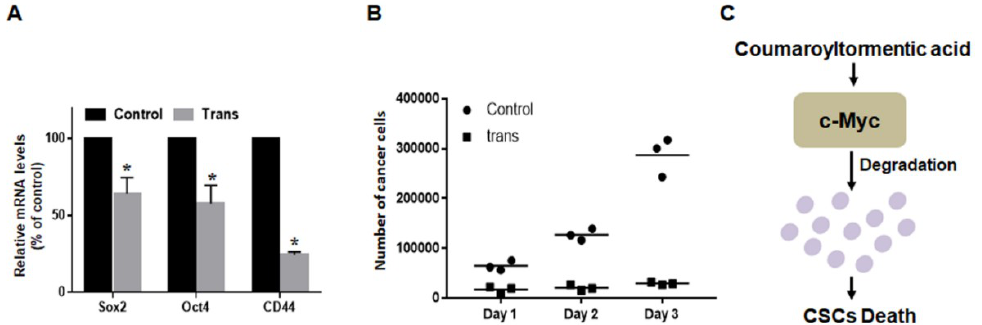
Figure 6. Effect of 3 - O - trans - p -coumaroyltormentic acid on the gene expression of CSC markers and mammosphere growth. ( A ) Transcriptional expression of the CSC markers Sox2, CD44, and Oct4 genes was determined in 3 - O - trans - p -coumaroyltormentic acid-treated and DMSO-treated mammospheres using specific primers for these genes and real-time RT-PCR. β-Actin served as an internal control. ( B ) Effect of 3 - O - trans - p -coumaroyltormentic acid on mammosphere growth. 3 - O - trans - p -coumaroyltormentic acid prevents mammosphere growth. After 3 - O - trans - p - coumaroyltormentic acid and DMSO treatment for two days, the mammospheres were dissociated